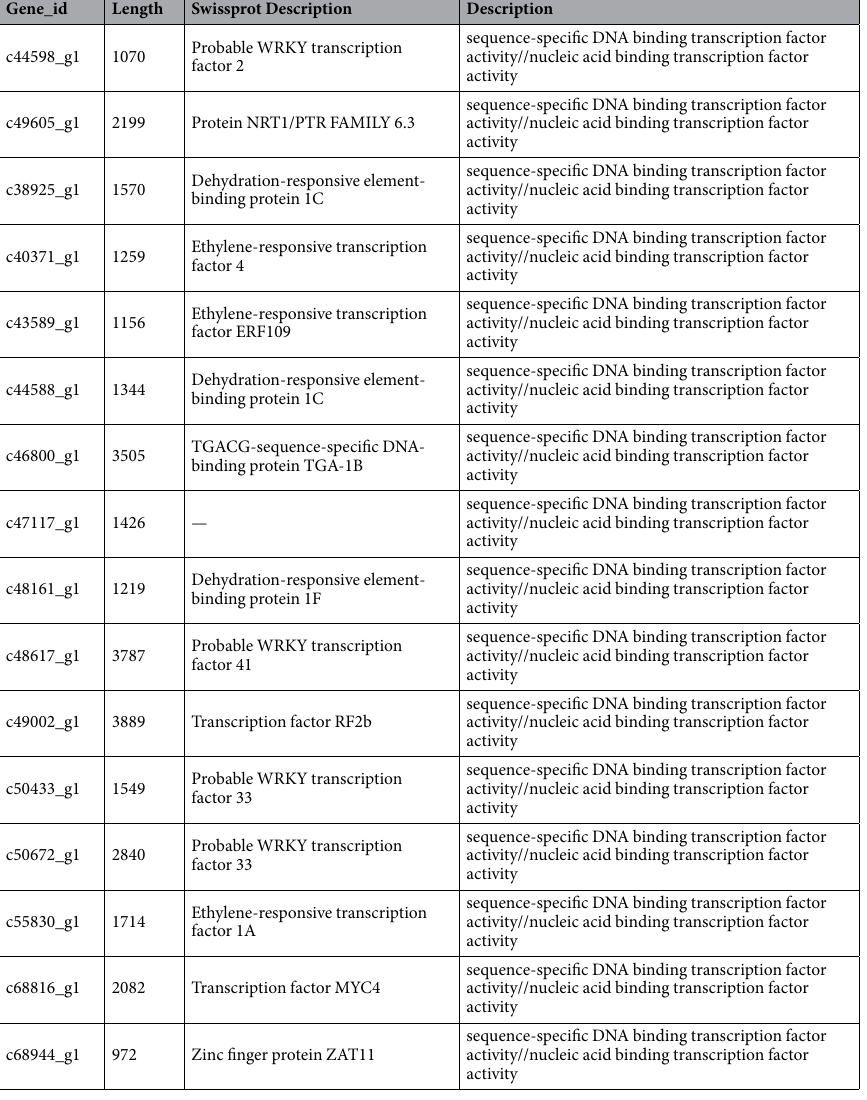
Table 4. The differentially expressed transcription factors in AM vs AC enriched on two GO